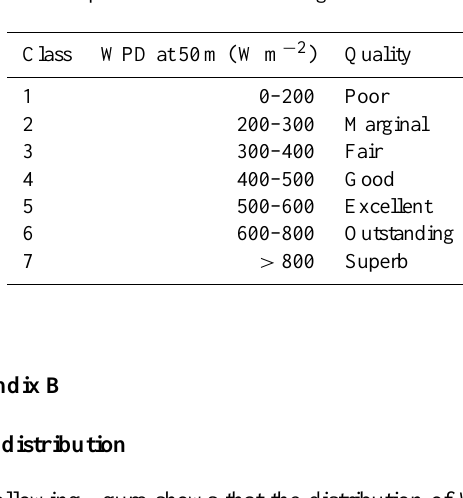
Table A1. Wind power classes at 50m height.